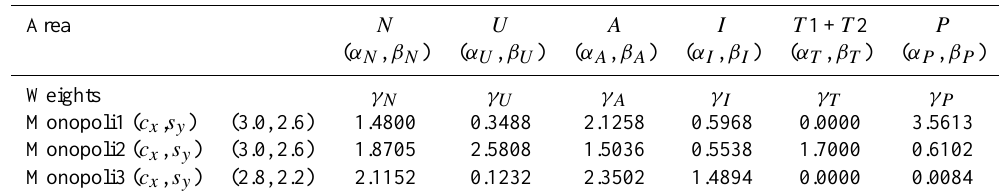
Table 4. Adjusted pressure areas according to weighted coefficient of criticality and sensitivity for monitoring the change due to City plan